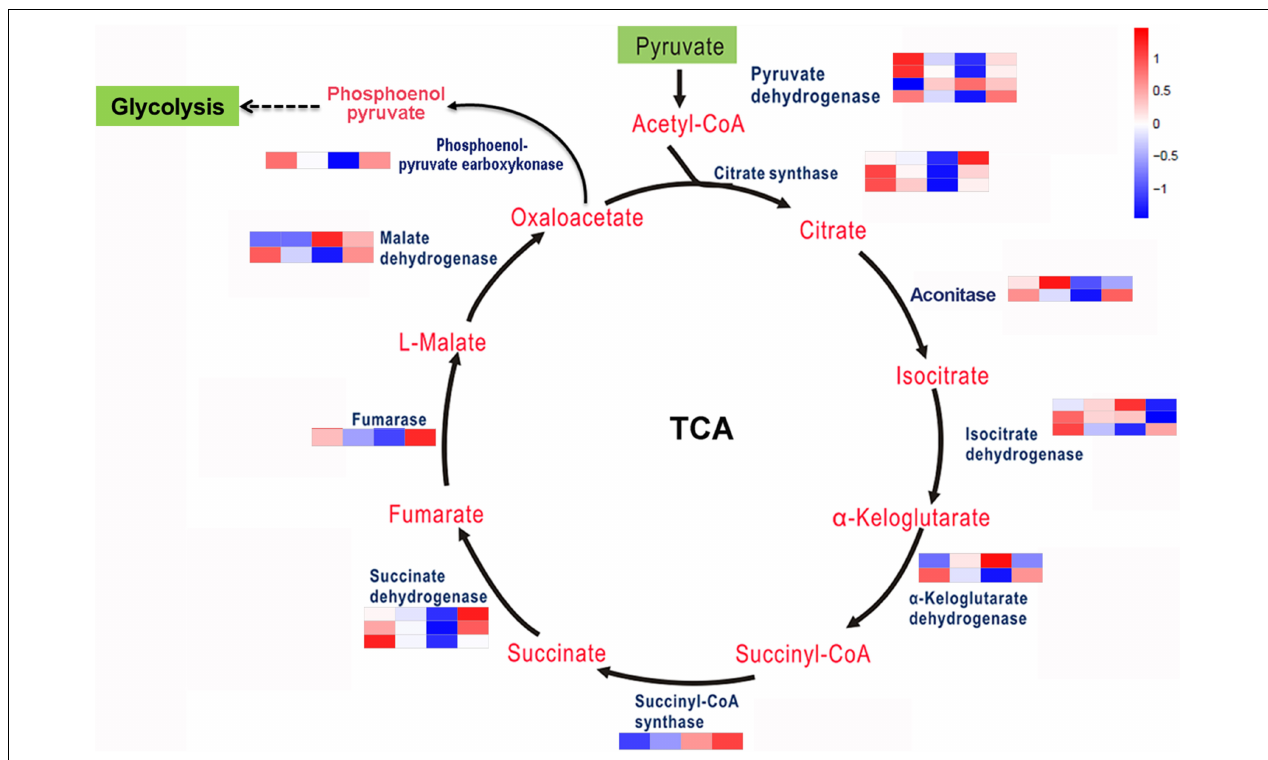
FIGURE 4 | Key enzymes encoded by the DEGs involved in the carbohydrate metabolism are enriched by KEGG